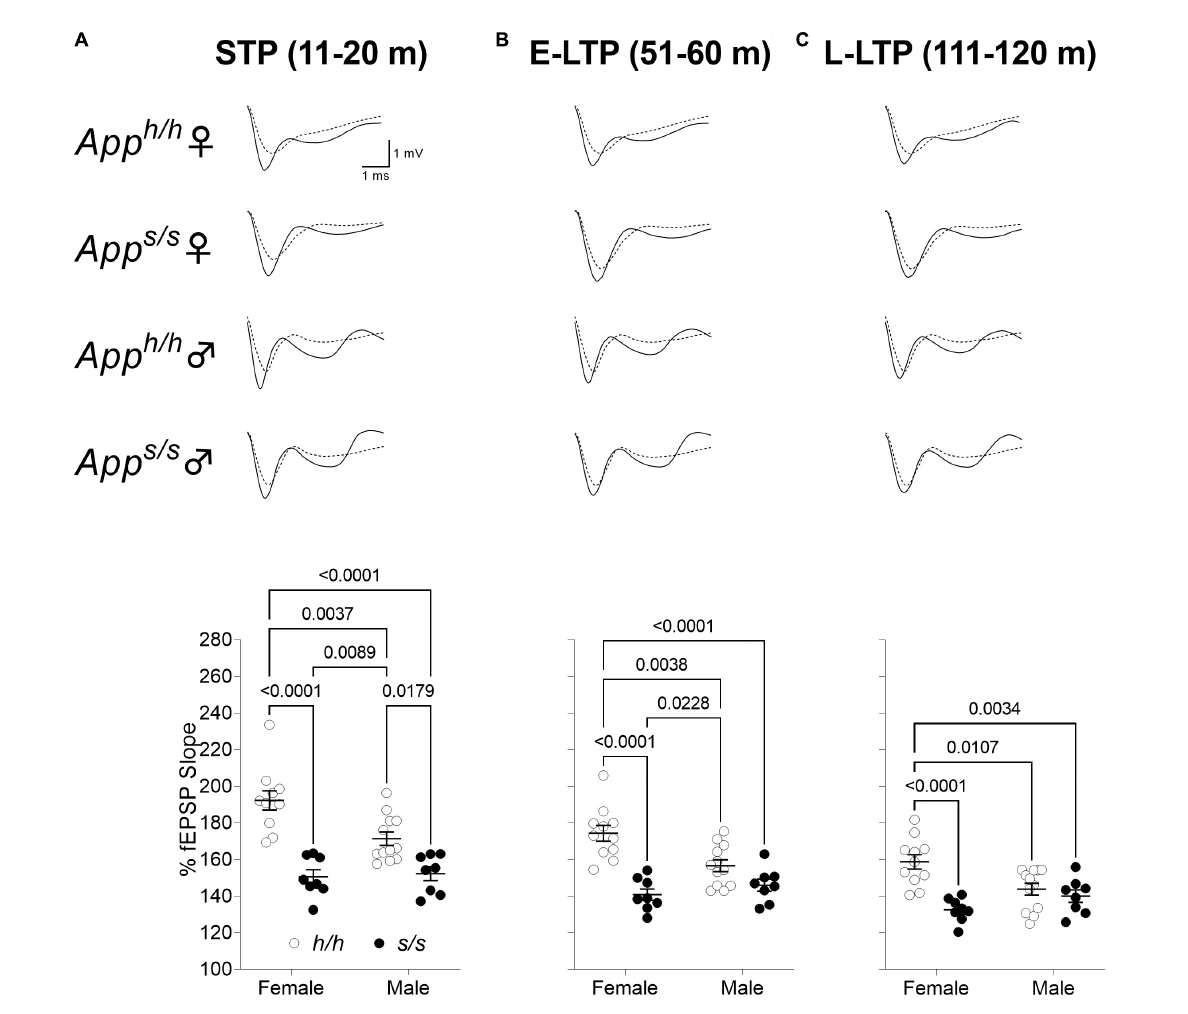
FIGURE11 Swedish mutation impaired all phases of LTP. (A) Plot of fEPSP slope change in 11–20 m (short term potentiation, STP). The average traces of the baseline (dotted line) and STP (solid line) are shown on top. (ANOVA summary; sex factor, F ( 1 , 35 ) = 4.820, p = 0.0349; genotype factor, F ( 1 , 35 ) = 48.38 p < 0.0001; sex × genotype interaction, F ( 1 , 35 ) = 6.638, p = 0.0144). (B) Plot of fEPSP slope change in 51–60 m (early LTP, E-LTP). The average traces of the baseline (dotted line) and E-LTP (solid line) are shown on top. (ANOVA summary, sex factor, F ( 1 , 35 ) = 2.850, p = 0.1002; genotype factor, F ( 1 , 35 ) = 35.18 p < 0.0001; sex × genotype interaction, F ( 1 , 35 ) = 9.448, p = 0.0041). (C) Plot of fEPSP slope changes in 111–120 m (late-LTP, L-LTP). The average traces of the baseline (dotted line) and L-LTP (solid line) are shown on top. (ANOVA summary, sex factor, F ( 1 , 35 ) = 1.134, p = 0.2942; genotype factor, F ( 1 , 35 ) = 18.46 p = 0.0001; sex × genotype interaction, F ( 1 , 35 ) = 10.23, p = 0.0029). Data are represented as mean ± SEM. Data were analyzed by one-way ANOVA for repeated measures followed by post-hoc Tukey’s multiple comparisons test when ANOVA showed statistically significant